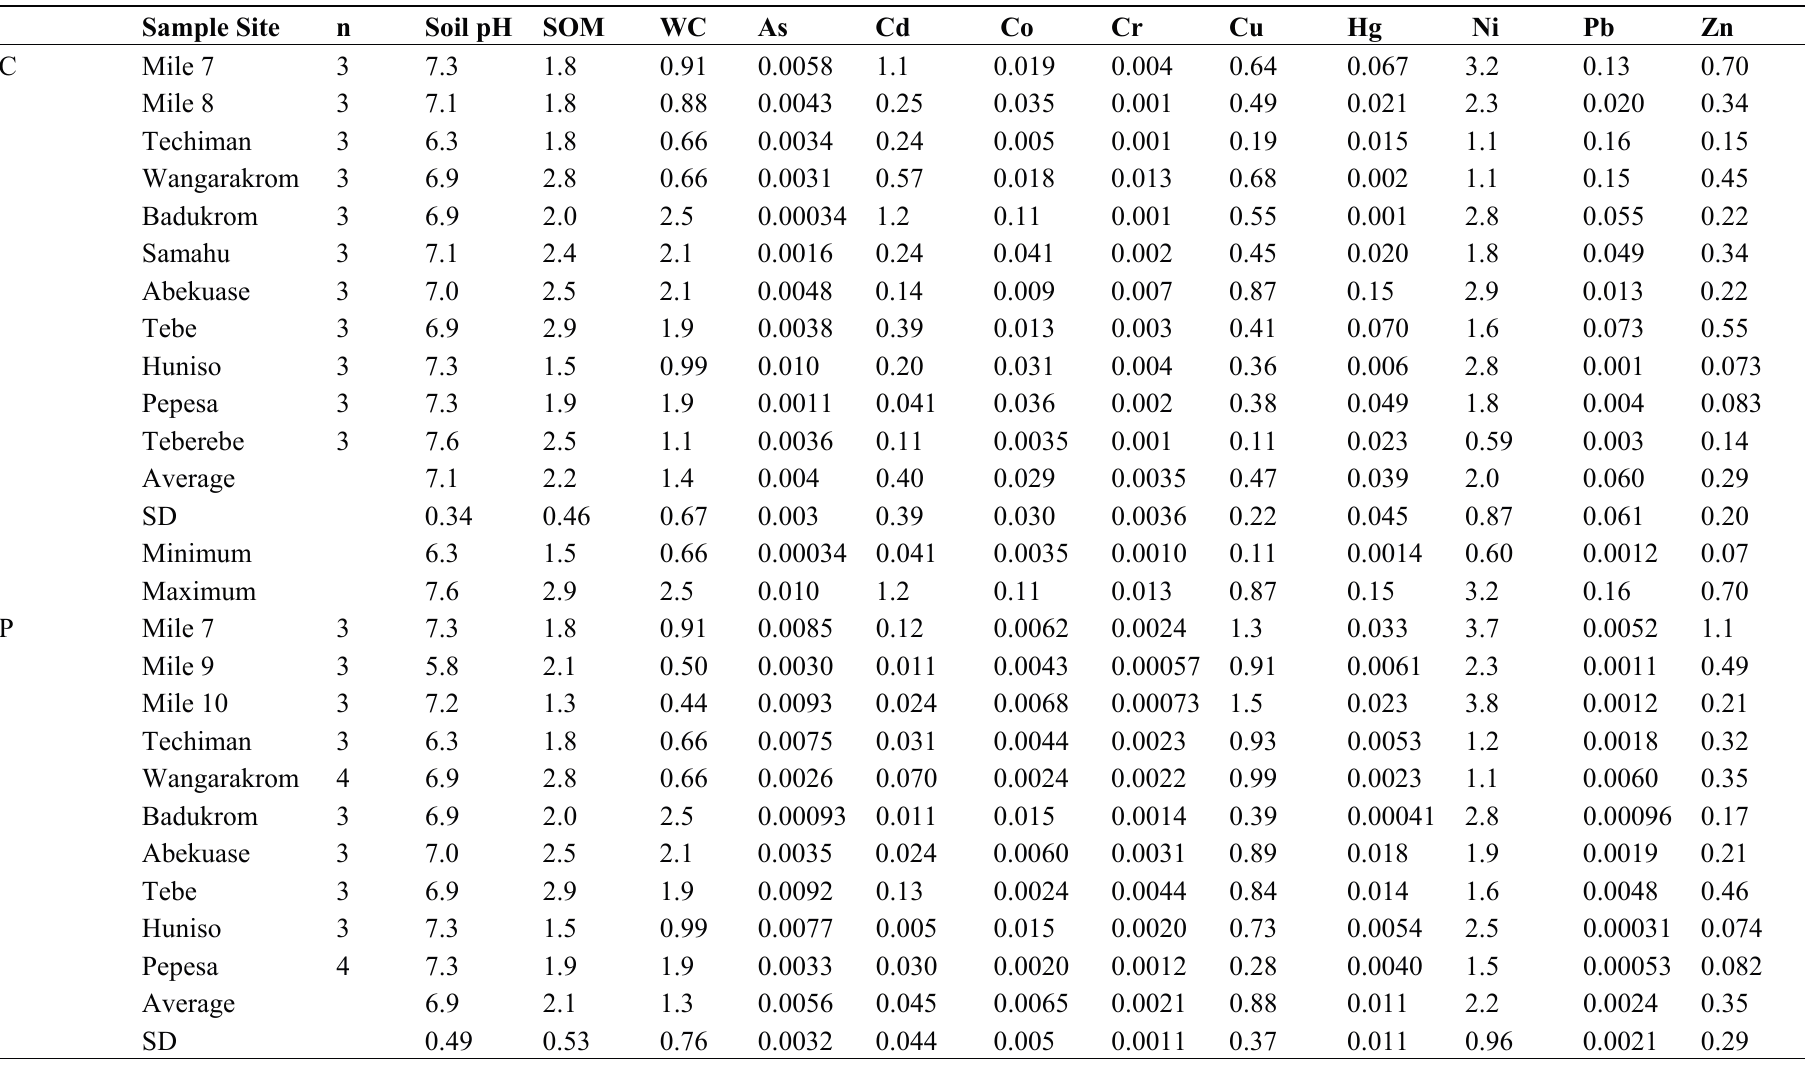
Table 2. Average soil pH, organic matter, water contents, and bioconcentration factors (BCF) of heavy metals and metalloid in foodstuffs from agricultural soils in